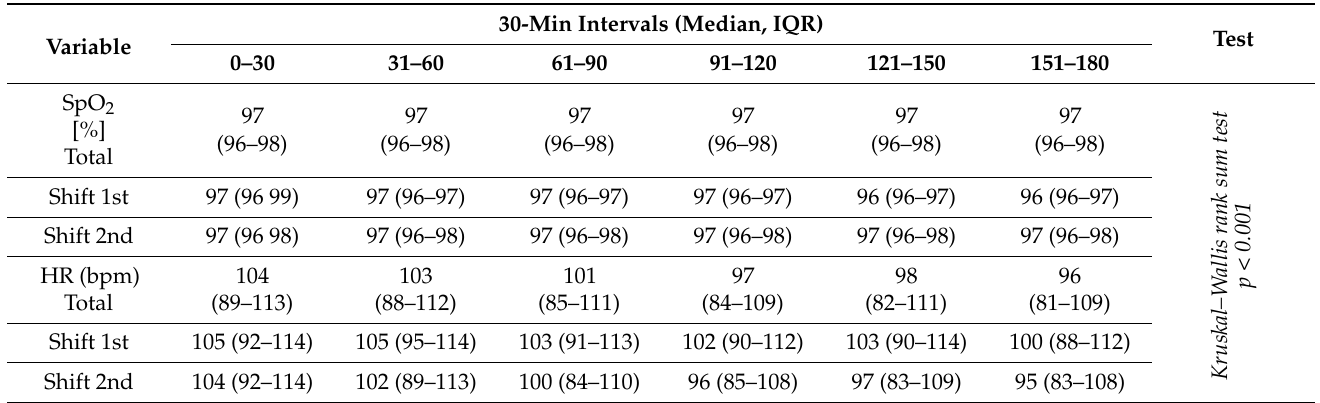
Table 2. The median (IQR) of the total and for shifts 1 and 2, respectively, in 30-min intervals for SpO 2 and heart rate (HR).